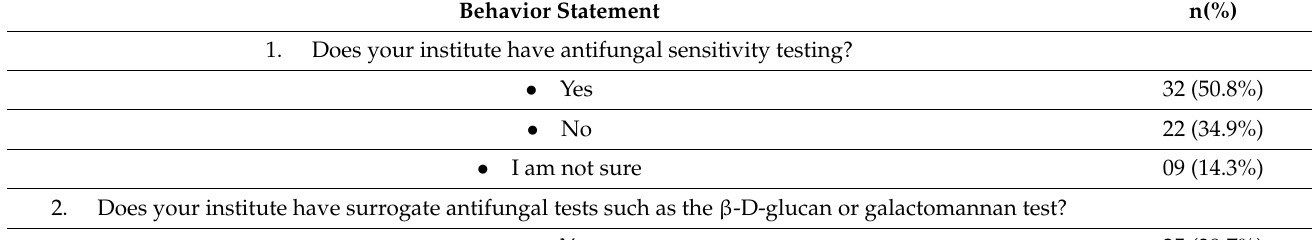
Table 3. Assessment of institution-related factors affecting antifungal prescribing practice .